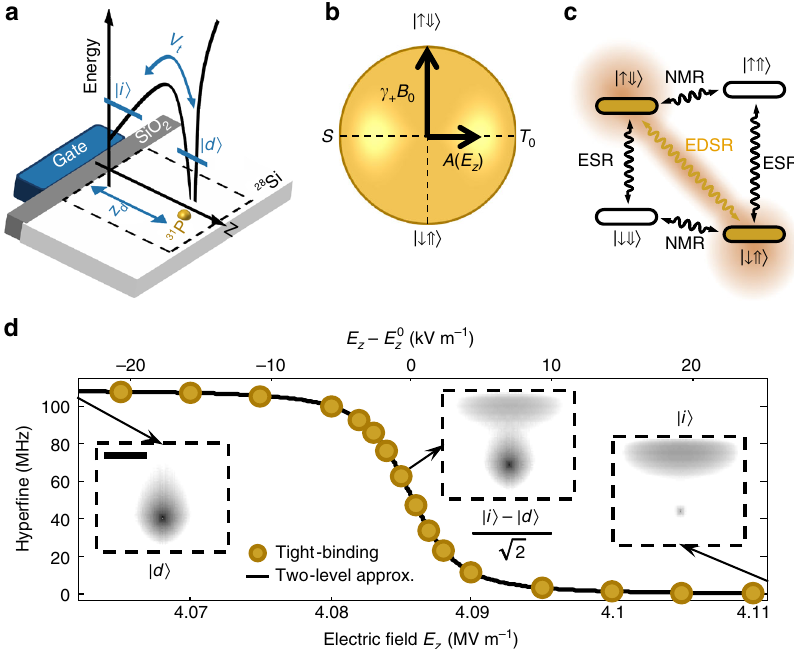
Fig. 1 Coupling donor spin qubits to electric fi elds via hyper fi ne modulation. a Qubit unit cell, in which the electron interface state, | i 〉 , is coupled to the donor-bound state, | d 〉 , by a tunnel rate V t . The solid black line represents the conduction band pro fi le along z . b Bloch sphere of a fl ip- fl op spin qubit coupled to a vertical electric fi eld E z via the hyper fi ne interaction A . Electron-nuclear singlet and triplet states are denoted by S ¼ #*j i (cid:3) "+j ið Þ = ffiffiffi p T 0 ¼ #*j i þ "+j ið Þ = 2 . c Si:P electron-nuclear spin levels, showing standard electron spin resonance ( ESR ) and nuclear magnetic resonance ( NMR ) transitions, together with hyper fi ne-enabled EDSR. d Atomistic tight-binding simulations 72 ( dots ) of the electron-nucleus hyper fi ne interaction, for a z d = 15.2 nm deep donor, as a function of vertical electric fi eld. The solid line is a fi t using the simpli fi ed two-level Hamiltonian H orb þ H orb GHz (see Supplementary Note 1). The insets show the electron ground-state wavefunction, g j i , in the region within dashed lines in a , for three different vertical electric fi elds. Scale bar is 10